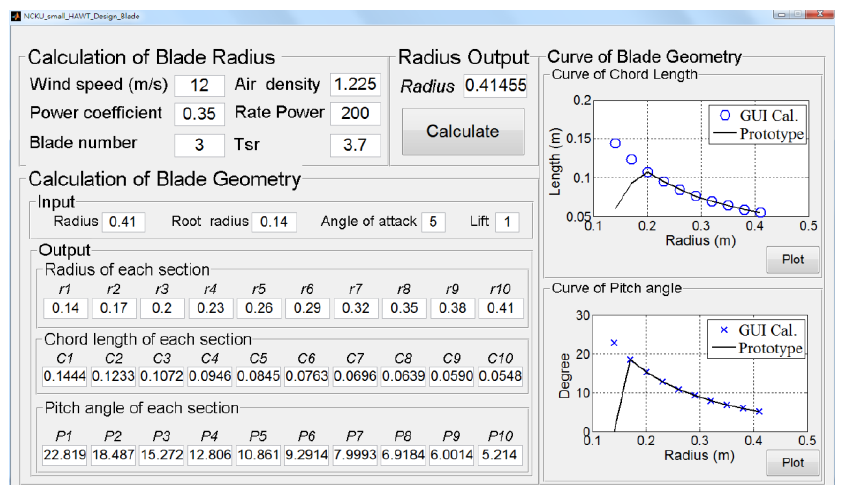
Figure 5. The analysis by HAWT-Blade.